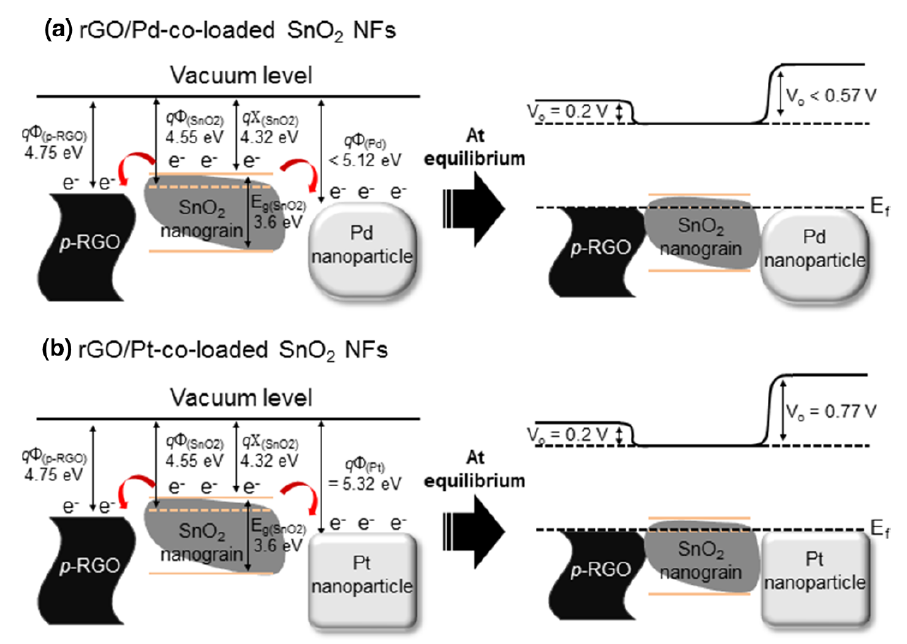
Figure 13. Energy band of ( a ) rGO, SnO 2 Pd, and ( b ) rGO, SnO 2 Pt [67].